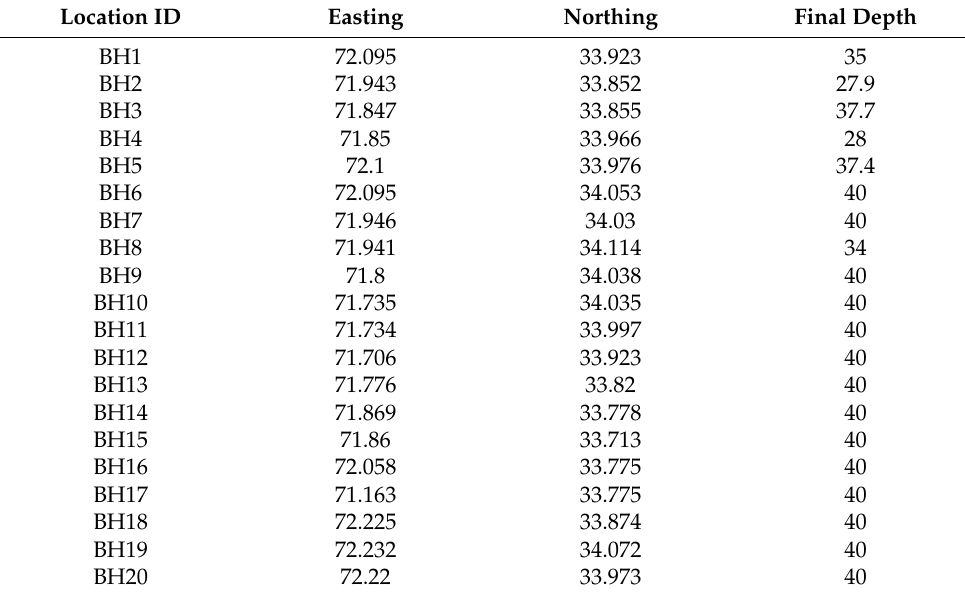
Table 2. The location and final depth of the